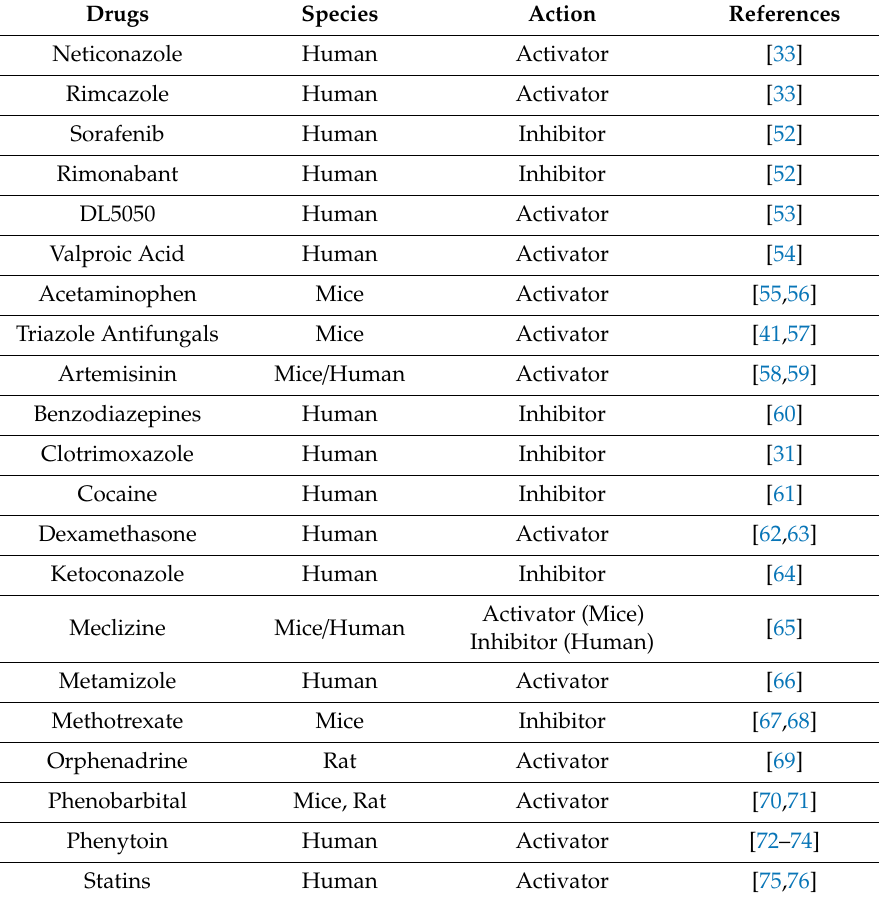
Table 3. Drugs presenting activation or repression action on